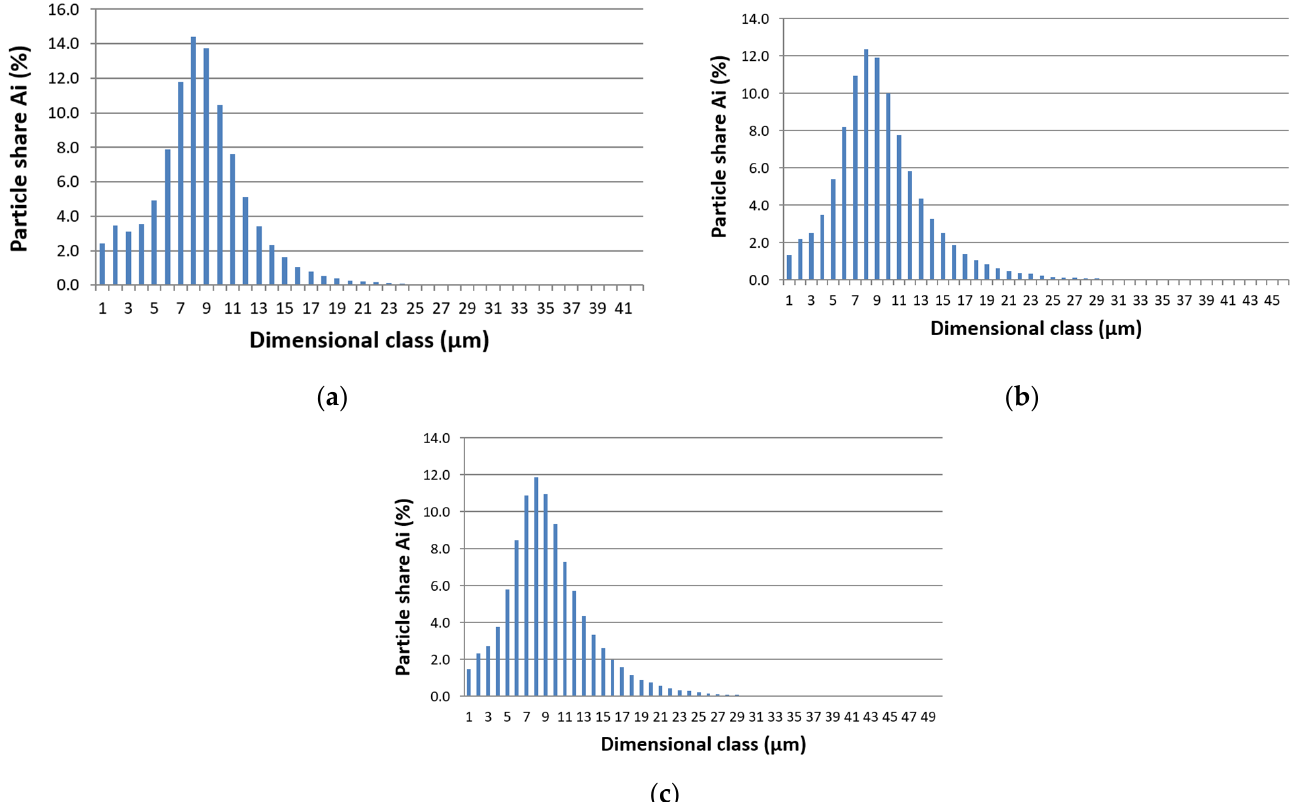
Figure 9. Sample result of the quantitative share of particles in a given class during measurements for the following measuring points: ( a ) nr 1; ( b ) nr 2; ( c ) nr 3.